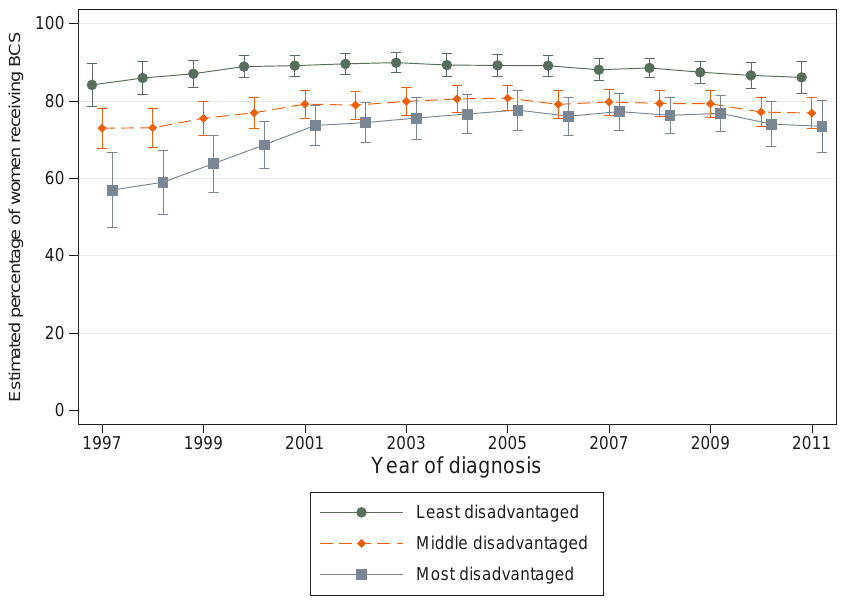
Figure 2. Estimated number of women with localised breast cancer out of 100 (percentage) undergoing BCS by residential disadvantage and year of diagnosis, Queensland 1997–2011.